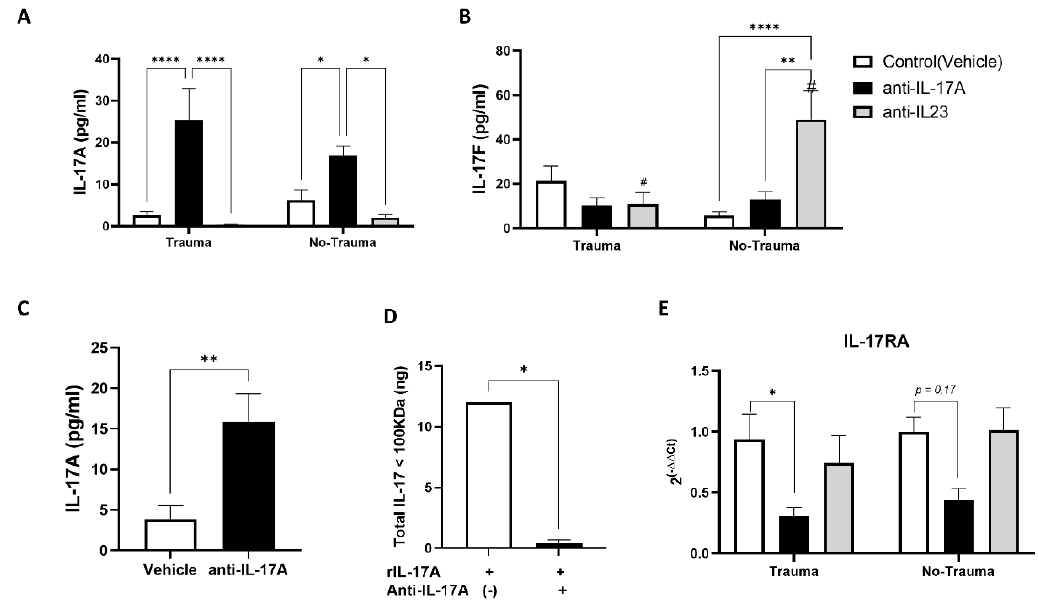
Figure 2. Antibody treatment affects IL-17 serum levels. Serum collected from mice at the end of the experiments (2.5 weeks post-trauma exposure) was analyzed for the protein levels of IL-17A ( A )